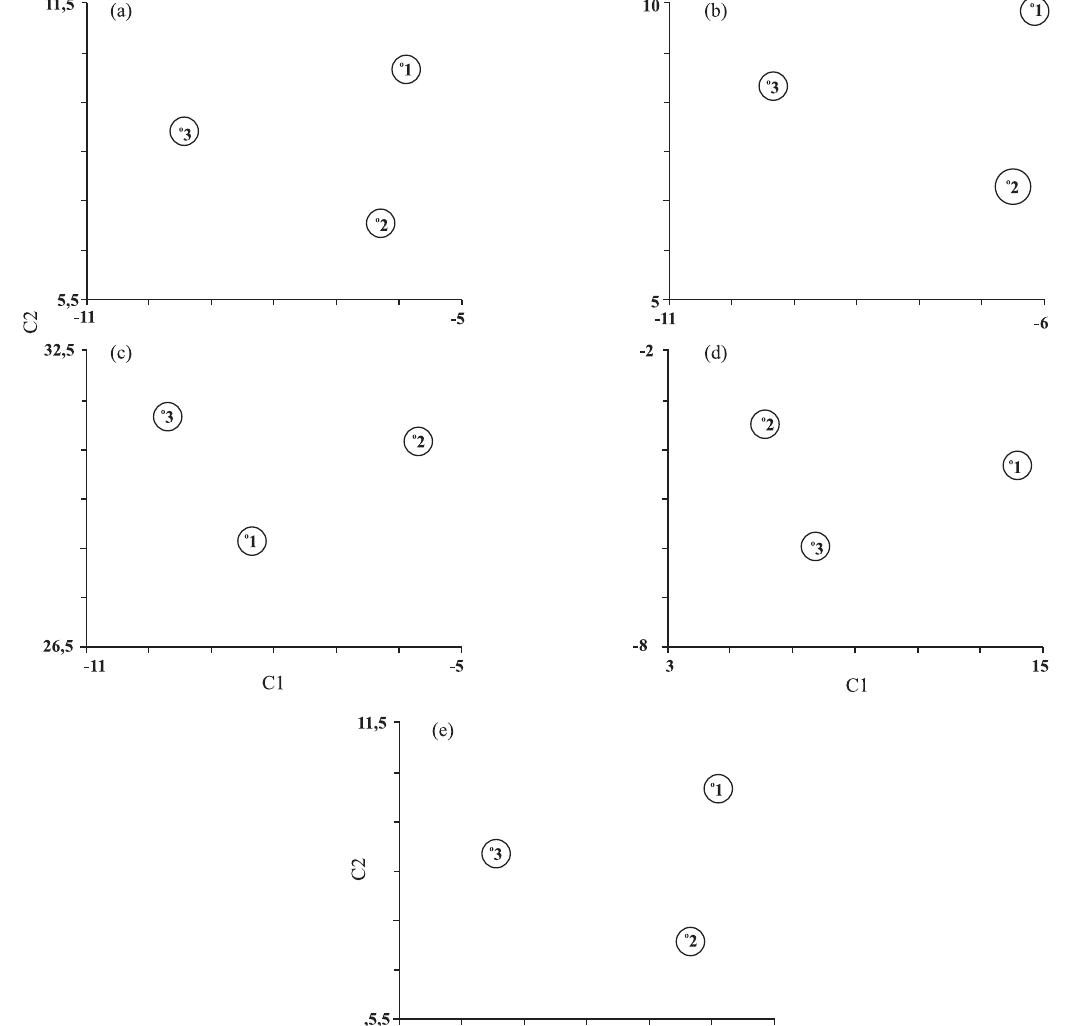
Figura 3. Dispersão gráfica em relação aos dois primeiros componentes principais, com base nas variáveis de conteúdo de C, N, P, K, Ca e Mg na parte áerea (a), folhedo (b), serapilheira (c), solo (d) e solo + planta (E) de diferentes coberturas florestais no sudeste da